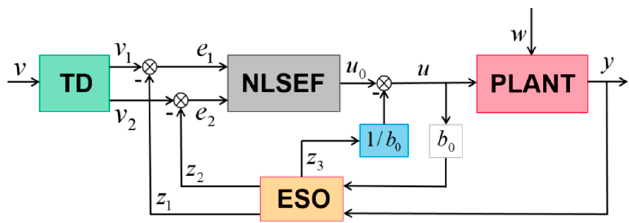
Figure 2. Weight coefficient distribution.